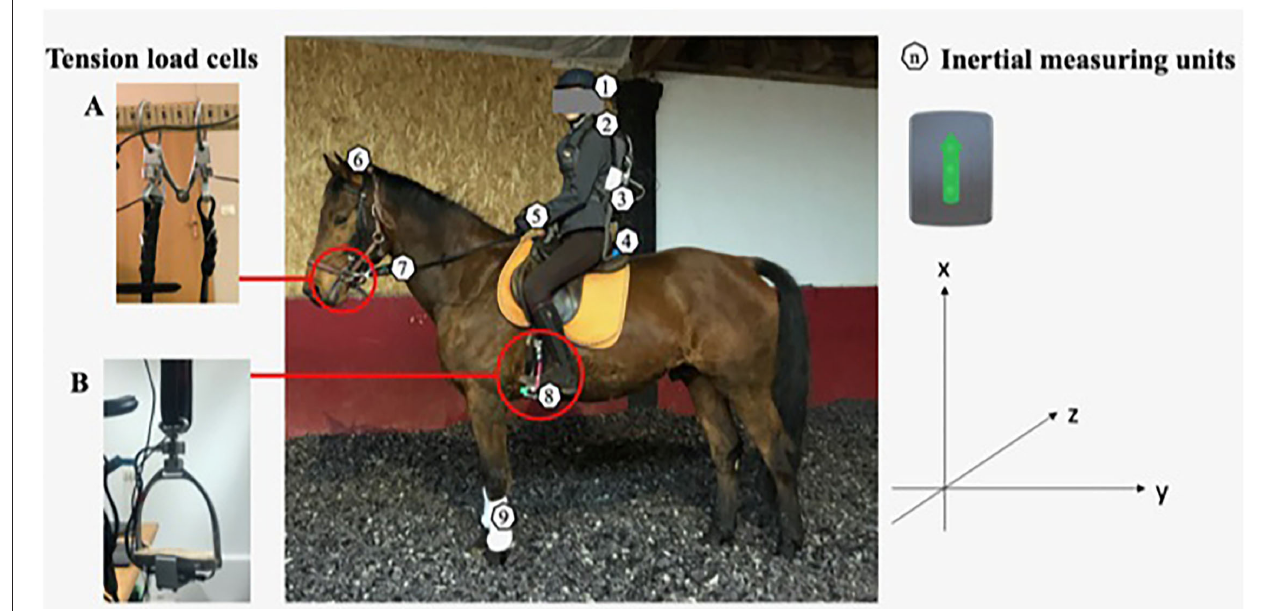
FIGURE 2 | Placement and orientation of the tension load cells of the (A) bridles and (B) stirrups and the inertial measuring units (IMUs). (1) Helmet, (2) C7, (3) S1, (4) cantle of the saddle, (5) wrists, (6) horse poll, (7) distal part of the rein, (8) base of the stirrup, and (9) forelimb of the horse. Forces at the junction between the reins and the rings of the snaffle bit, and the junction between the stirrups and the stirrup leathers were registered.